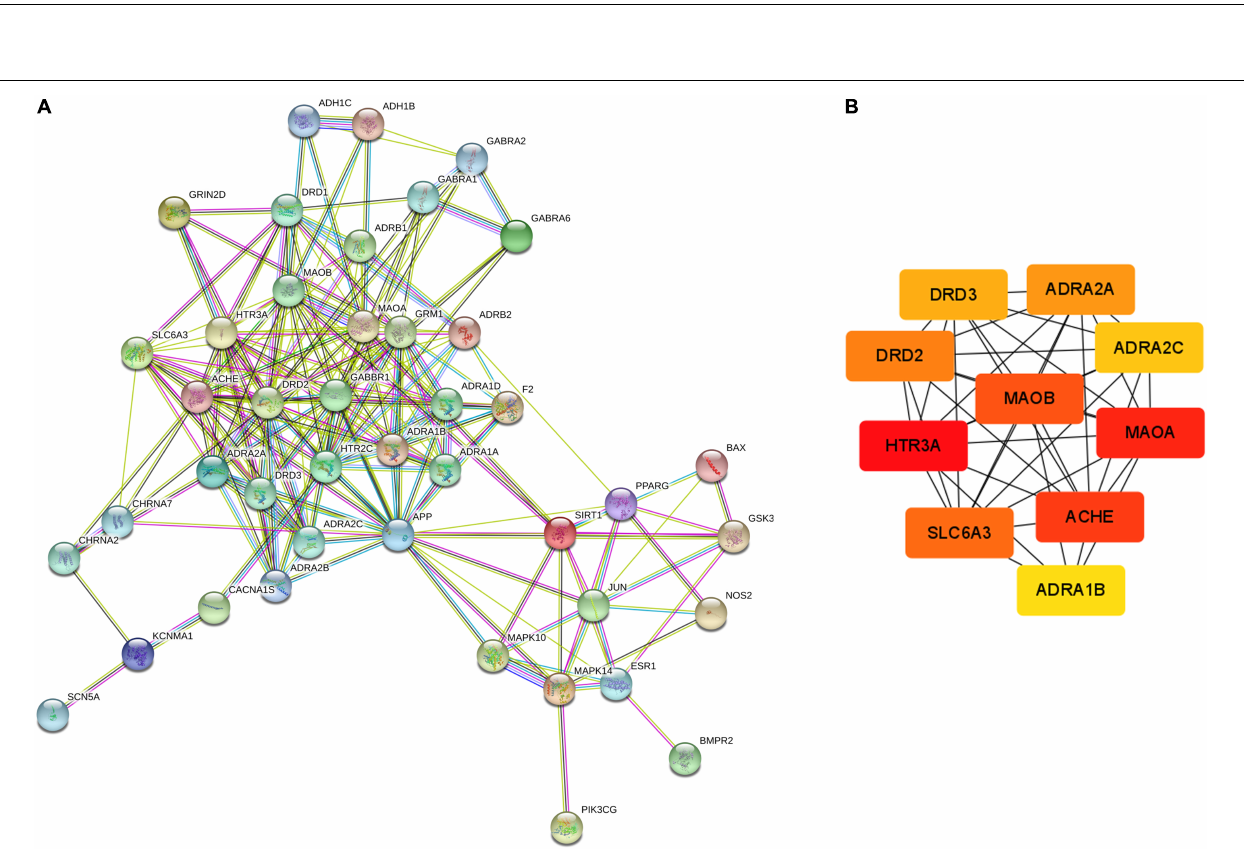
Frontiers in Molecular Neuroscience |